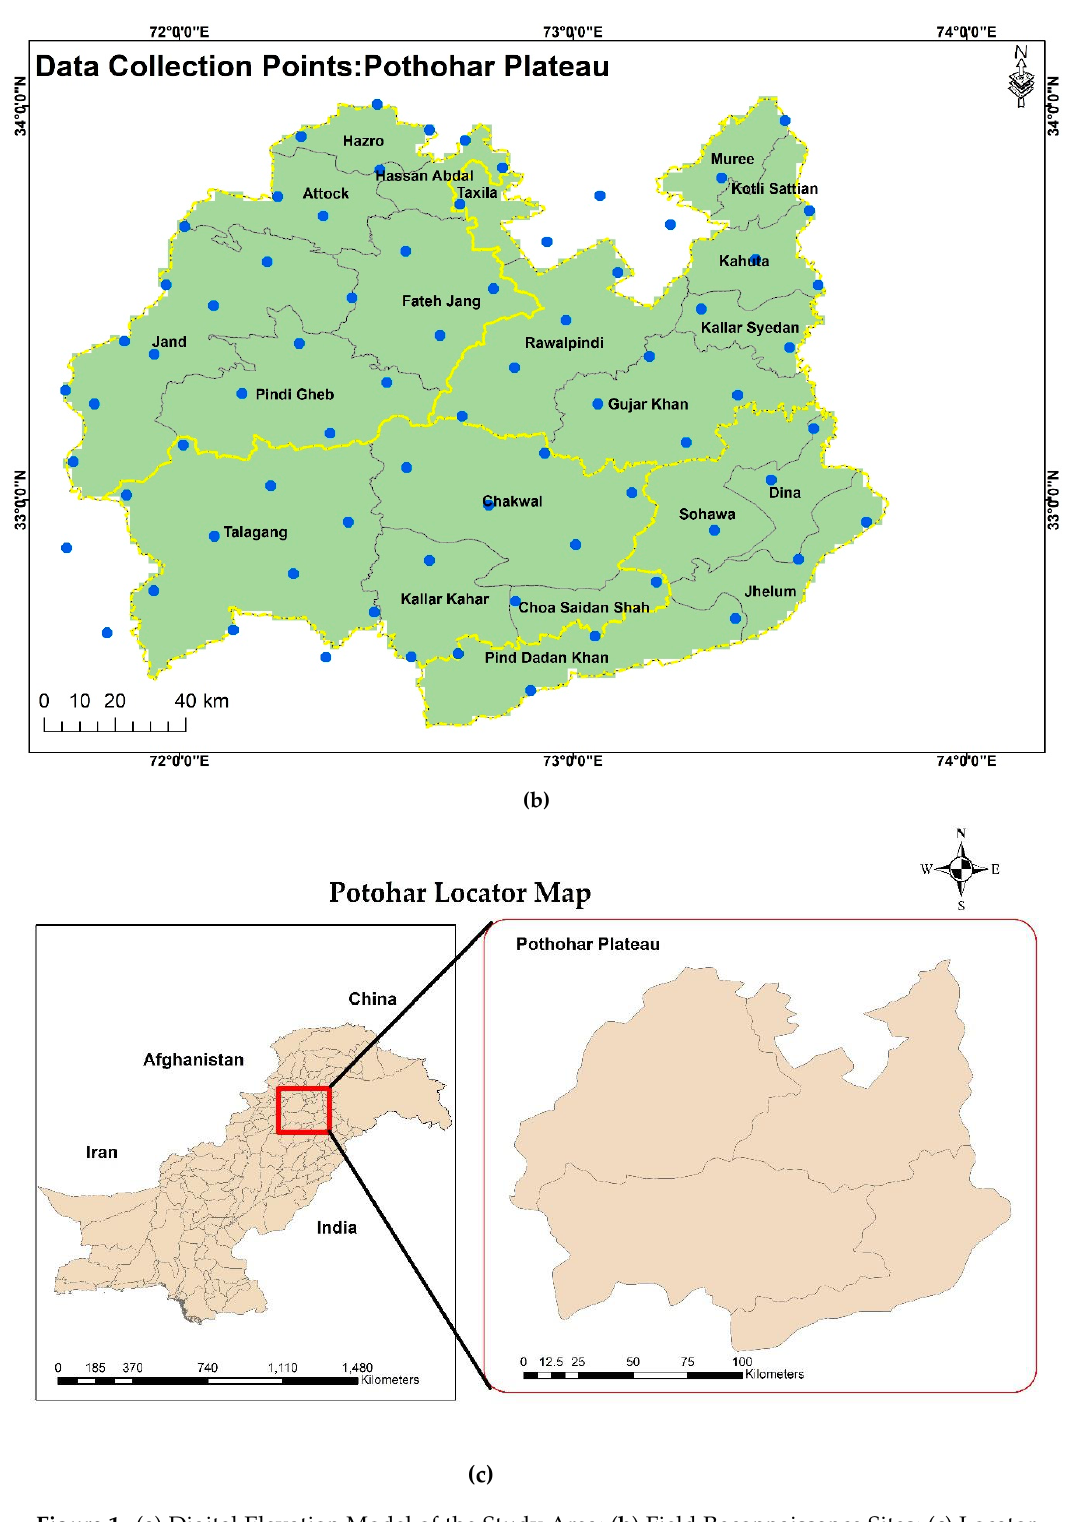
Figure 1. (a) Digital Elevation Model of the Study Area; ( b ) Field Reconnaissance Sites; ( c ) Locator Map of the Study